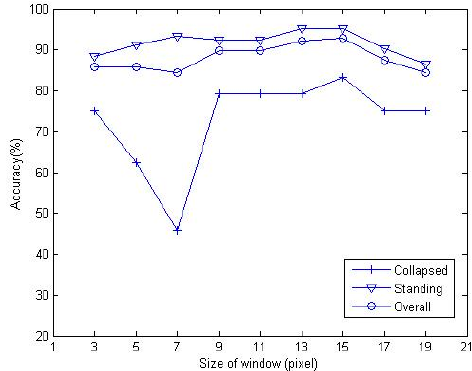
Figure 11. Influence of window size on the overall accuracy and the accuracy of the classification results of texture features for collapsed and standing buildings.